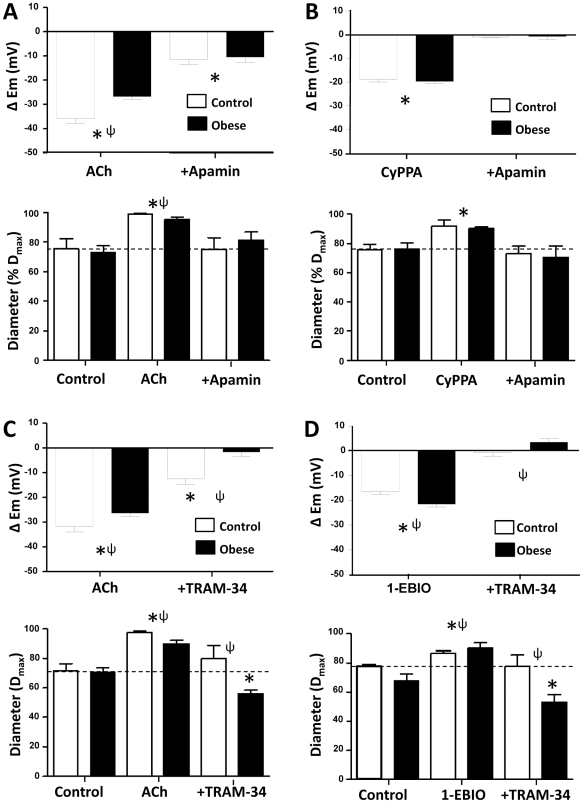
Selective SKCa and IKCa-mediated function.Inhibition of SKCa by apamin (50 nM) attenuates ACh (1 µM)-induced hyperpolarization in arteries from control and obese rats, and abolished the associated relaxation in control (A; Tables S2 and S3). Hyperpolarization and relaxation elicited by CyPPA (SKCa agonist; 30 µM) is abolished by apamin (B; Tables S2 and S3). EDH activity was abolished in arteries from obese rats following inhibition of IKCa, and was reduced in arteries from control rats (C; Table S3). Hyperpolarization and relaxation elicited by 1-EBIO (300 µM; activating IKCa) was larger in arteries from obese compared to control, with both being inhibited by TRAM-34 (D; Tables S2 and S3). *P<0.05 from own control; ψ, P<0.05 control compared to obese. ΔEm, change in membrane potential from control.